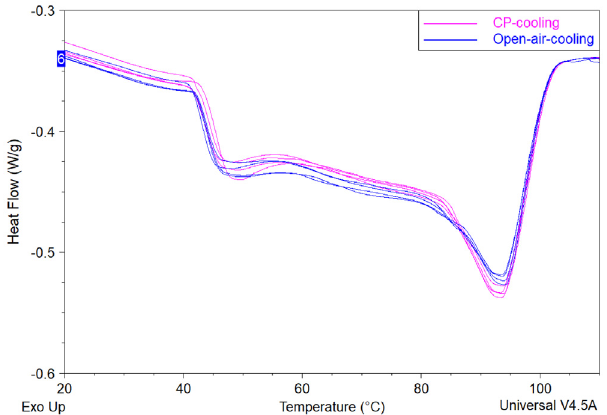
Fig. 6. DSC results for two samples of each cooling method which has been reproduced inside the calorimeter. REPRO-AIR are results from the reproduced natural convection cooling. REPRO-CP from the reproduced Cooling